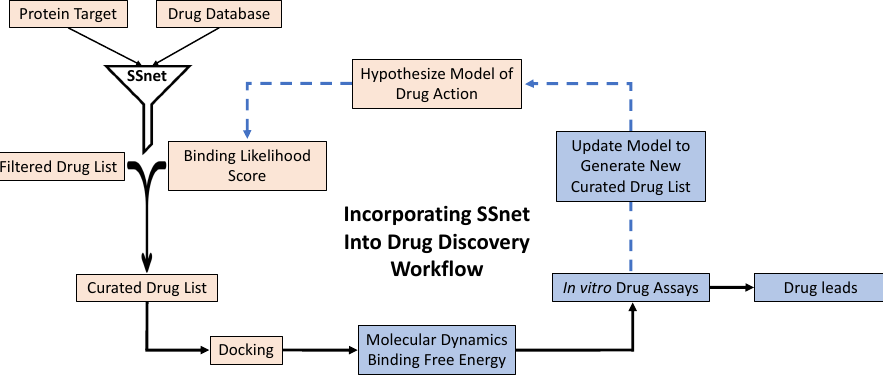
Figure 2. Proposed drug discovery workflow using SSnet. The orange boxes represent the steps that are performed in the present study. The blue boxes represent further steps required to complete the drug discovery workflow to obtain drug